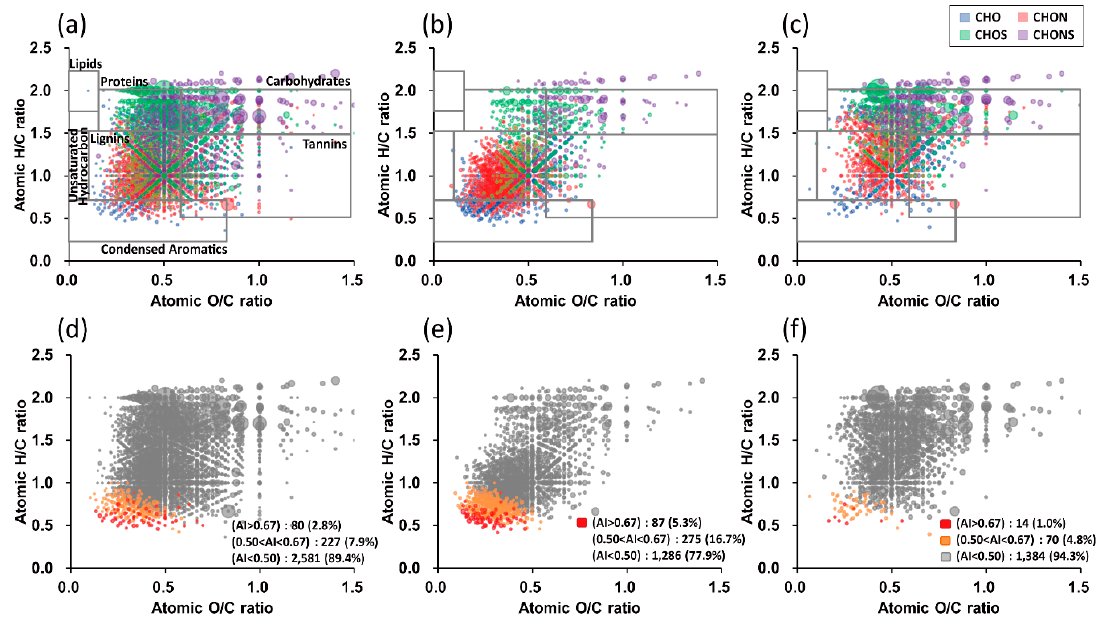
Figure 4. van Krevelen plots showing the distribution of chemical classes based on the molar H/C and O/C ratios for the assigned elemental compositions of the size-segregated aerosol-derived HULISs, which were analyzed by electrospray ionization (ESI) Fourier transform ion cyclotron resonance mass spectrometry (FT–ICR MS), in the stage three fractions (size cut: 1.1–2.1 μ m) during different sampling periods for ( a – c ), showing the molecular compound classes. Color code: CHO, blue; CHON, red; CHOS, green; and CHONS, purple. ( d – f ) Represent the presence of aromatic species (color code: AI < 0.5, gray; 0.5 < AI < 0.67 orange; AI > 0.67, red). ( a , d ) preheating, ( b , e ) main heating and ( c , f ) postheating periods. The size of each circle is proportional to the intensity of the molecular